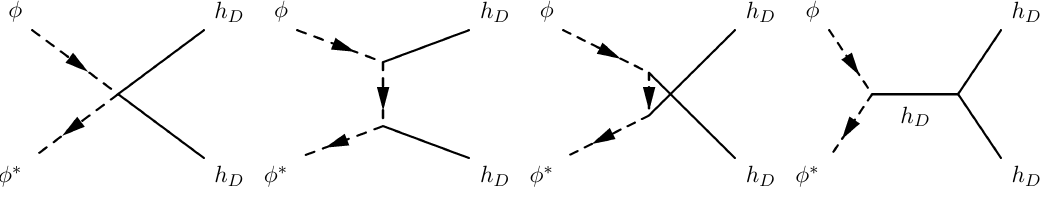
∗ φ → h D A D amplitude at tree level.